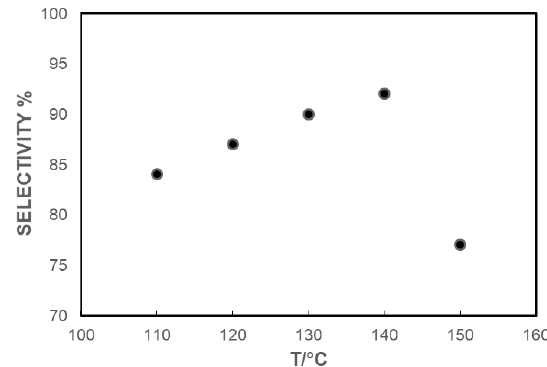
Figure 1. Optimization of the reaction temperature for the reductive cyclization of α-phenyl-β-nitrostyrene ( 1b ) to 2-phenylindole ( 2b ). Data from Table 2. The effect of the amount of base is moderate, but an almost linear increase in the selectivity is observed at 140 °C on passing from 20 to 120 μL of Et 3 N (Entries 4, 6–9 and